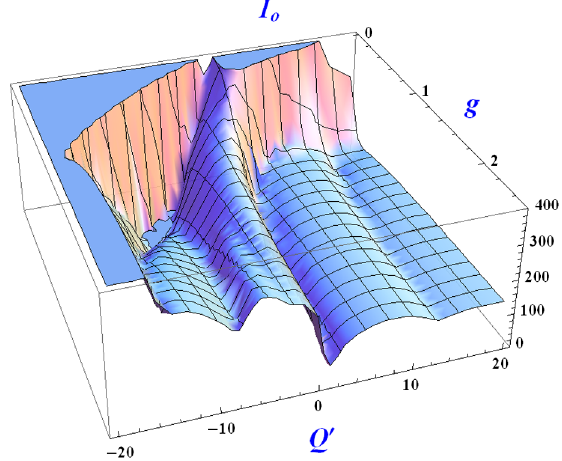
FIG. 15. Same as above, but for a full 50 ns single beam.